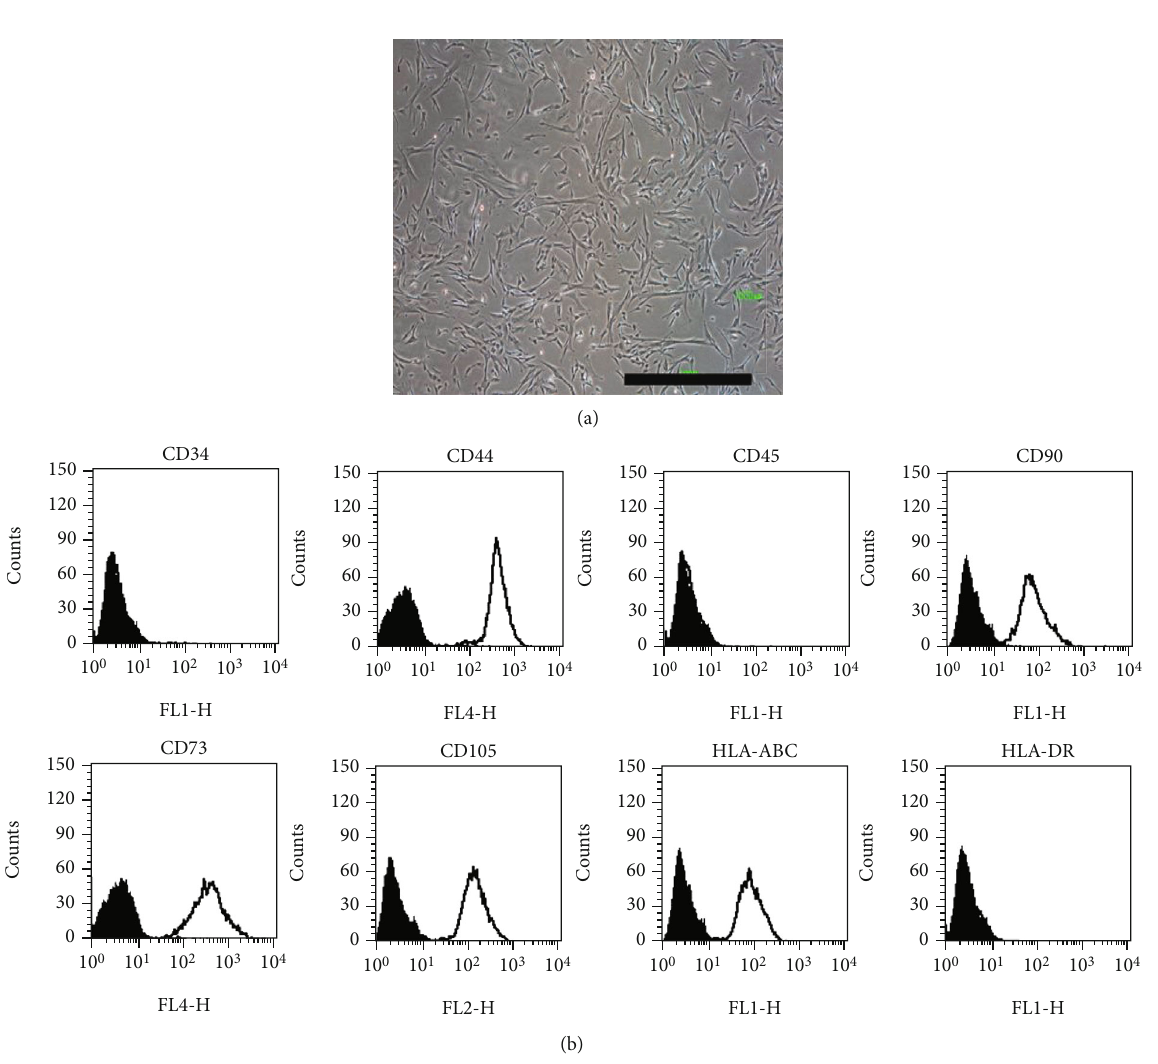
Figure 1: Morphology and surface markers of human umbilical cord mesenchymal stromal cells (HUCMSCs). (a) The morphology of HUCMSCs shows a fi broblastic-like appearance. (b) Surface marker panel of HUCMSCs. They are positive for HLA-ABC, CD44, CD90, CD73, and CD105 and negative for HLA-DR, CD34, and